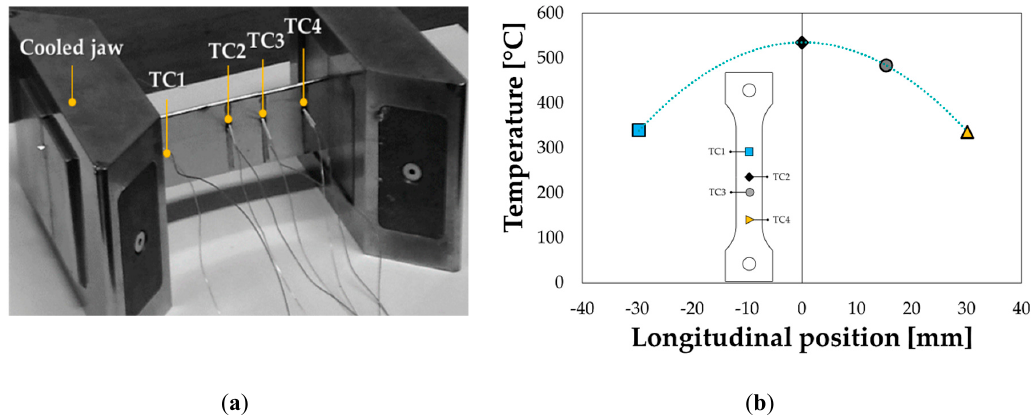
Figure 1. Solution Heat Treatment (SHT) tests: ( a ) thermocouple positioning; ( b ) resulting parabolic temperature distribution.